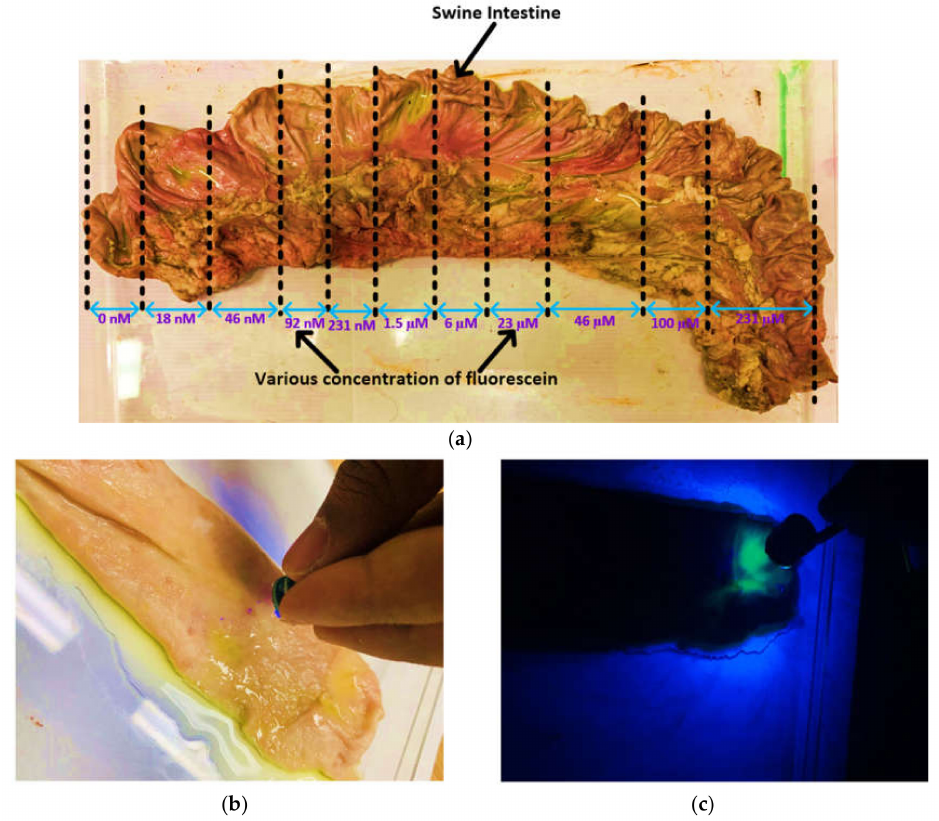
Figure 7. Screening of a porcine intestine by the capsule prototype: ( a ) various concentrations of fluorescein solution sprayed over the intestine; ( b ) demonstration of the capsule in working conditions; ( c ) demonstration of the capsule in working conditions when no external light is present.